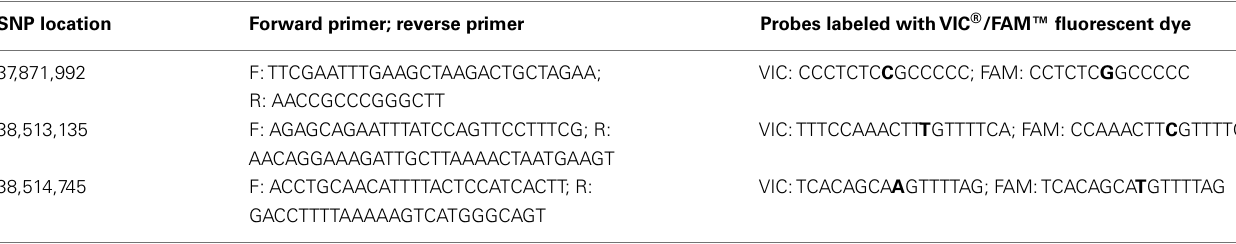
TableA3 | Specification of the primers and probes in the SNP genotyping assays.